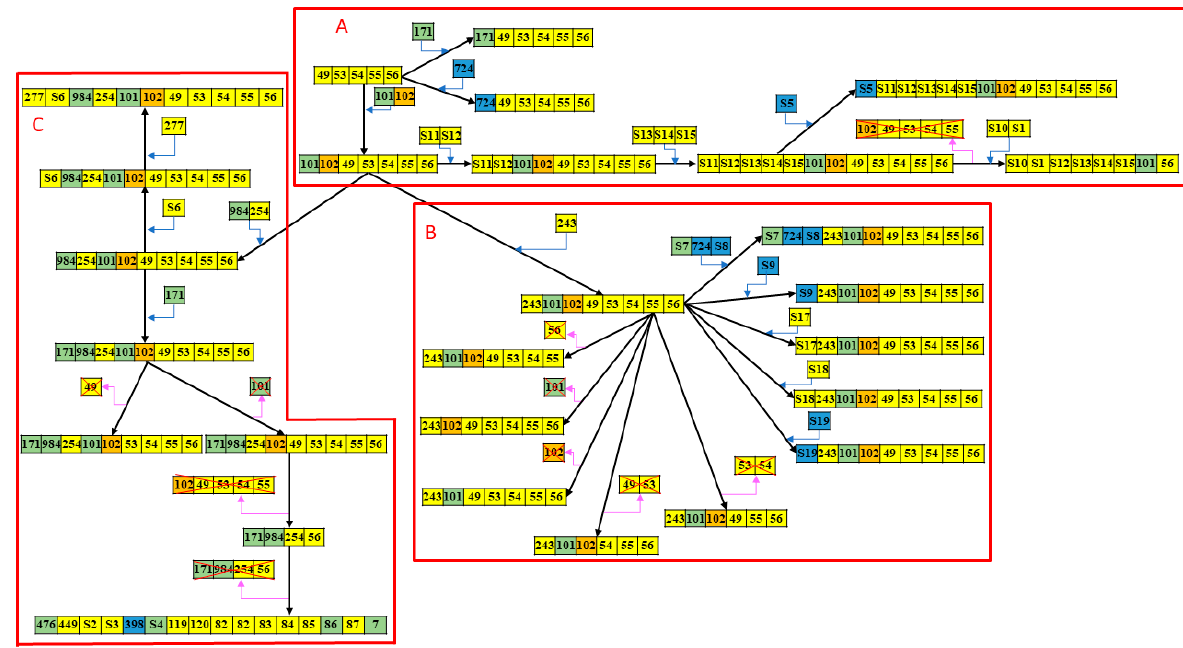
Figure 2. Phylogenetic relationship of 103 CRISPR-positive GBS strains constructed on 43 CRISPR types based on eBURST analysis. All 103 CC17/III GBS isolates can be categorized into three major subgroups ( A – C ) based on the CRISPR-RFLP array and eBURST analysis. The differences between compositions of CRISPR and gain or loss of spacers are marked and their relationships are presented. Table 2. Clinical presentations of 103 cases of GBS invasive diseases categorized based on the length